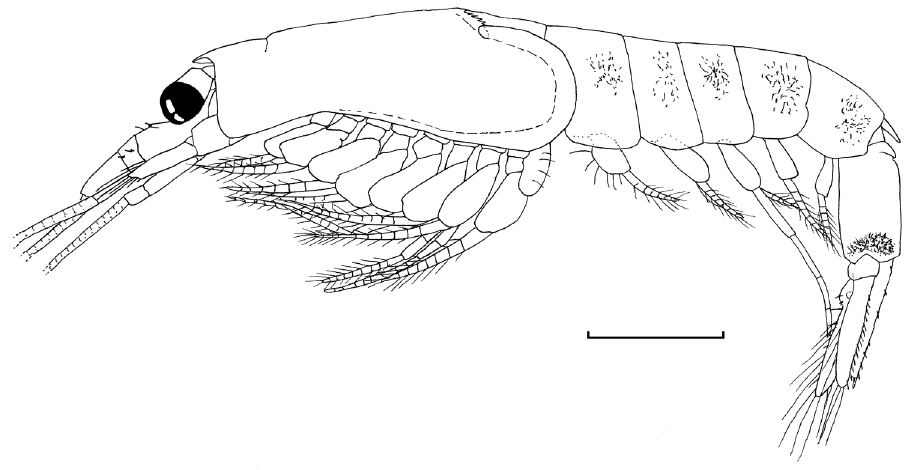
Figure 1. Gastrosaccus lombokiensis sp. n., entire body of paratype male (TL 6.9 mm) in lateral view. Scale = 1